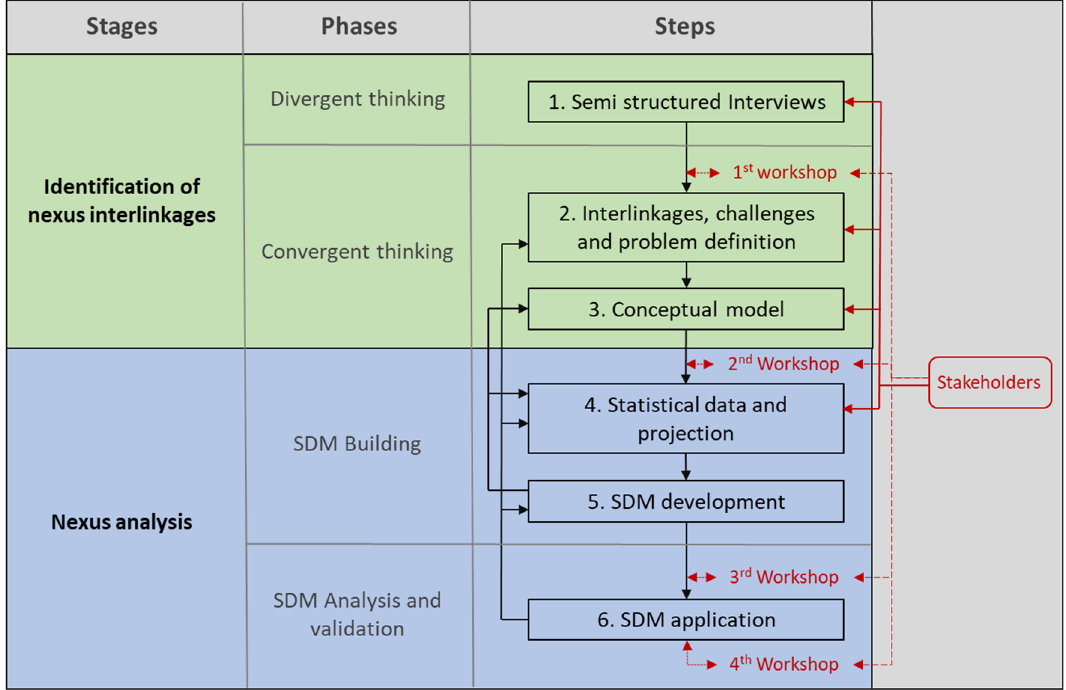
Figure 2. Overview of the steps in the development of the participatory system dynamics model. Source: our own elaboration.